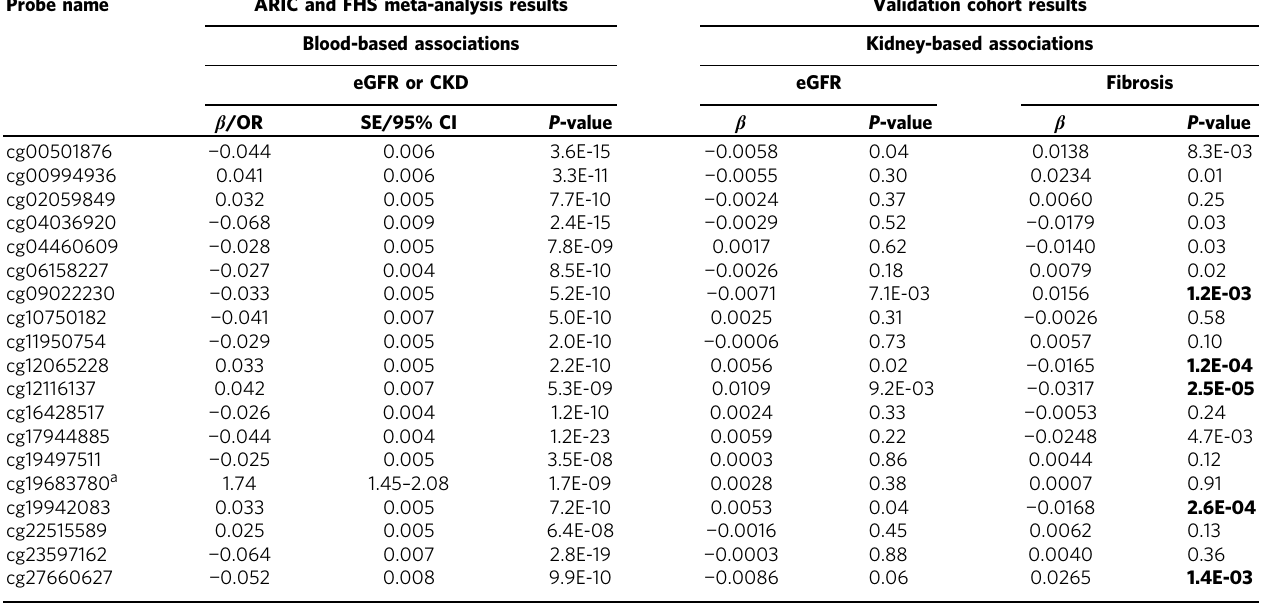
Table 4 Validated CpGs and their association between methylation in human renal tubular cells and kidney function (eGFR) as well as % renal fi brosis among patients with diabetic kidney disease. The Bonferroni threshold was set at 2.6e-3 = 0.05/19. Signi fi cant P -values are marked in bold. Human kidney methylation data is based on the data in Ko et al., Genome